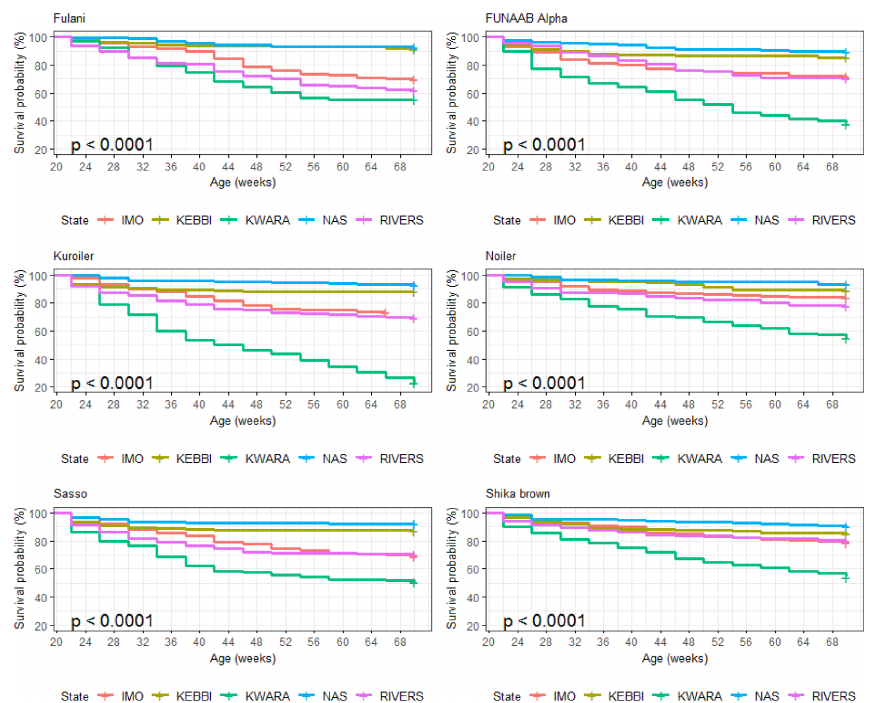
Figure 16. Breed by environment interaction on survivability of female birds (breeds) raised on-farm in ACGG Nigeria project zones (20–72 weeks) (2016–2018).